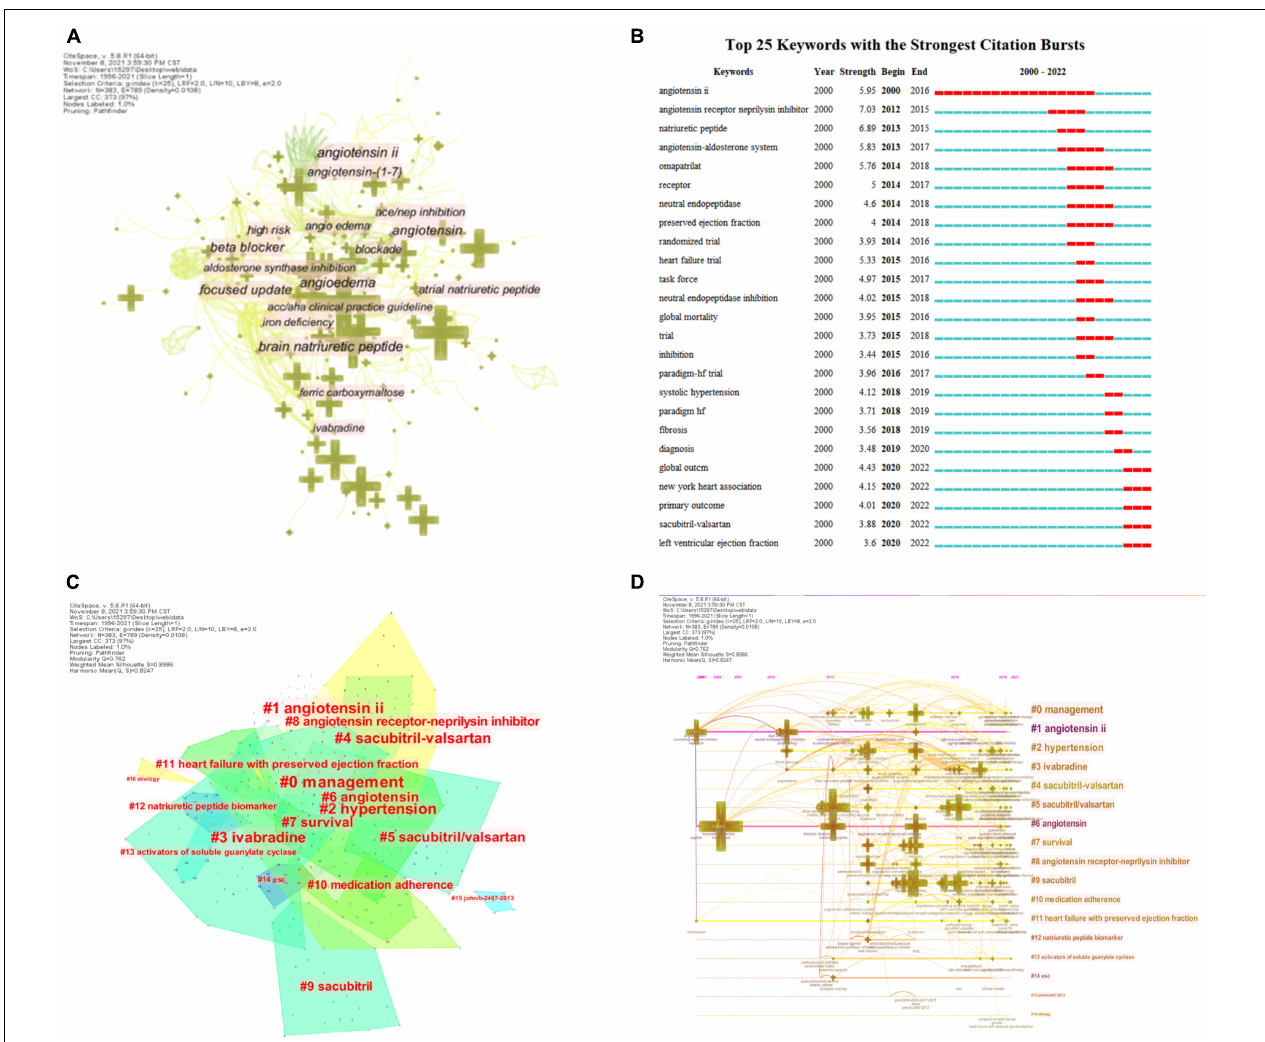
FIGURE 7 | CiteSpace visualization of keywords involved in ARNI research in the cardiovascular system. (A) Network of the main keywords in publications on ARNI in cardiovascular system research and related research. (B) Time trend graph of burst keywords. (C) Cluster analysis of keywords. (D) The timeline view of Keyword